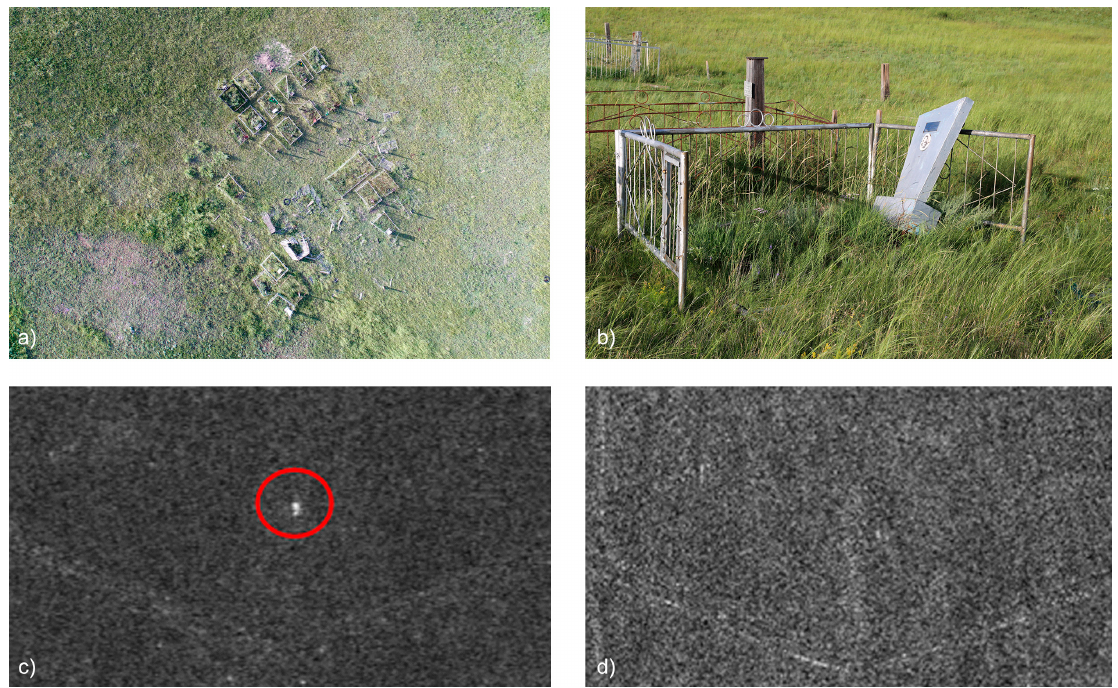
Figure 9. ( a ) Drone image of the modern cemetery showing an anomaly in the PALSAR-2 image; ( b ) a possible explanation for the strong backscatter of this area or the grave markers welded from metal sheets and the surrounding fences. PALSAR-2 slant-range image of the cemetery: ( c ) HV and ( d ) HH. © JAXA